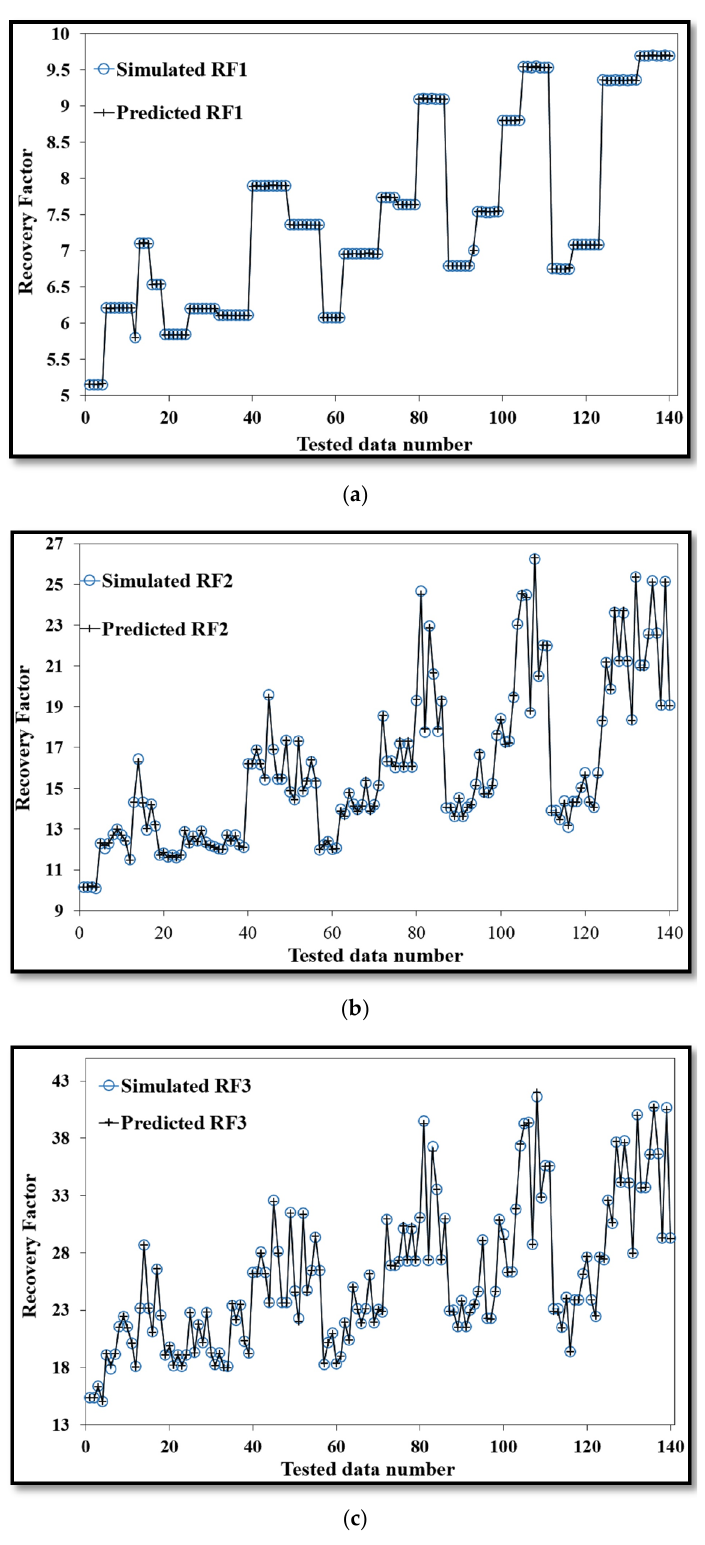
Figure A3. Illustration of the simulated data against the predicted data during the testing process for ( a ) RF 1 , ( b ) RF 2 , and ( c ) RF 3 .